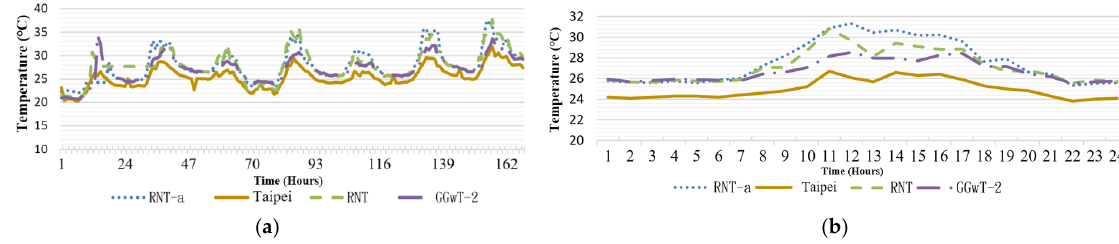
Figure 10. ( a ) Rooftop temperature without greening ( b ) partial observation on 21 May.